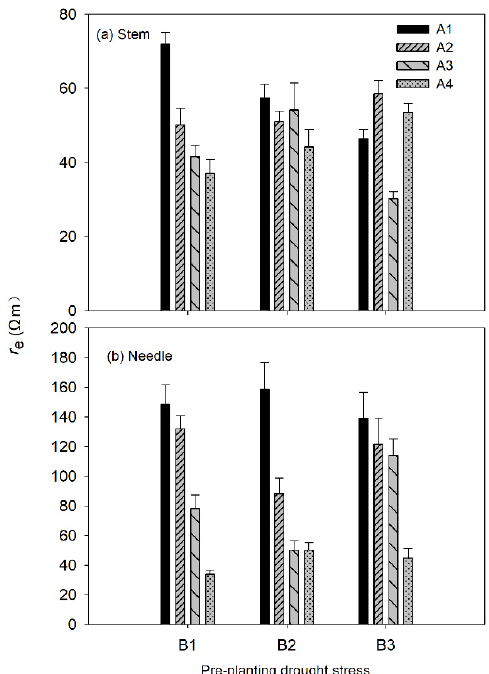
Figure 2. Extracellular resistance ( r e ) of stems ( a ) and needles ( b ) in lacebark pine seedlings by four weeks of post-planting drought treatments (A1, A2, A3, and A4). A1, 75%–80% soil relative water content (SRWC); A2, 55%–60% SRWC; A3, 35%–40% SRWC; and A4, 15%–20% SRWC. B1, adequate irrigation before planting; B2, 5 days of drought before planting; and B3, 10 days of drought before planting.